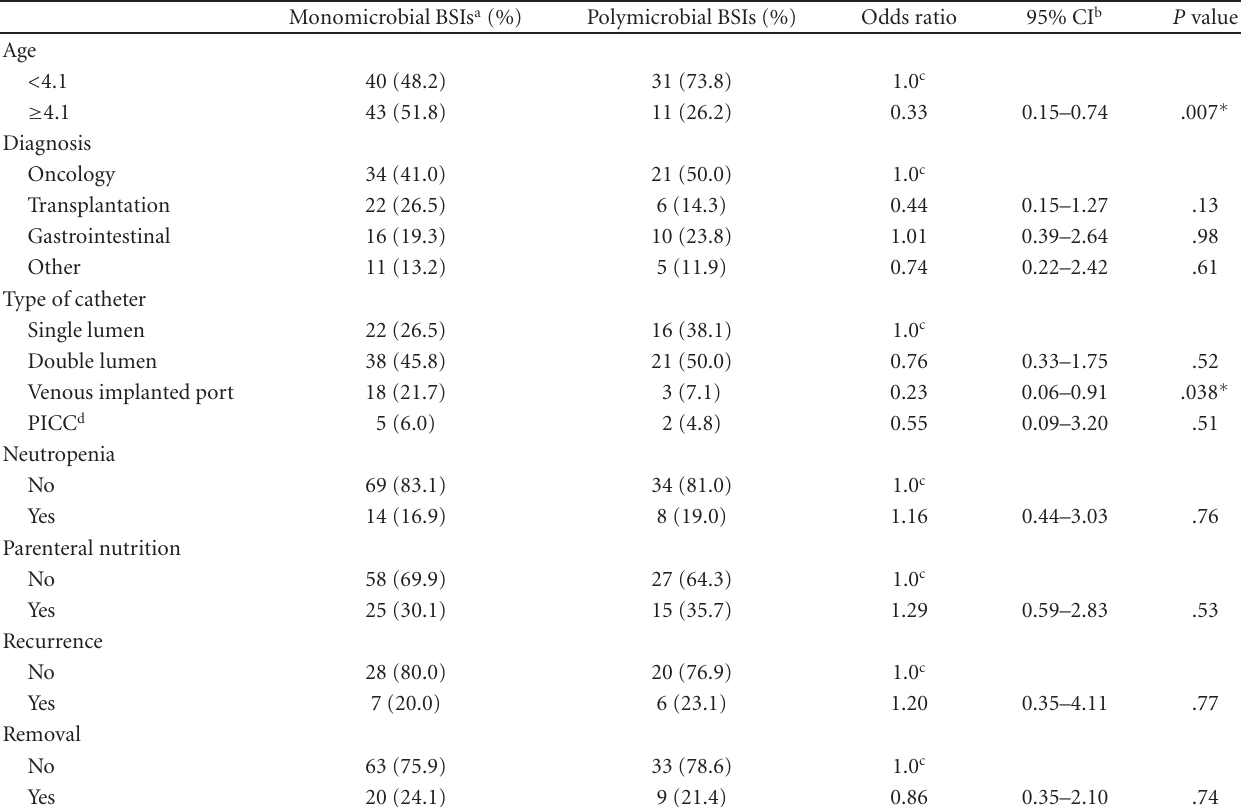
Table 3: Associations between polymicrobial/monomicrobial BSIs and the di ff erent risk factors and outcome. Monomicrobial BSIs a